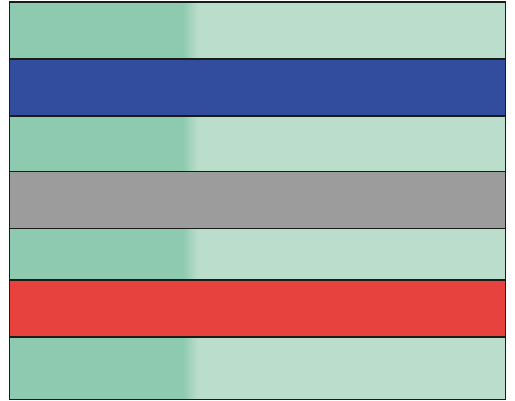
Figure 3: Simultaneous comparison phenomenon